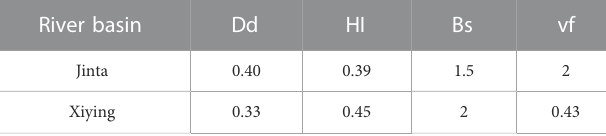
TABLE 3 Comparison of geomorphic parameters of Jinta and Xiying River Basins. River